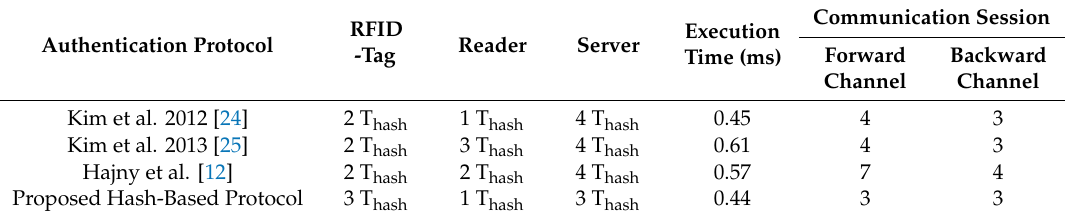
Table 4. Comparison cost of computation e ffi